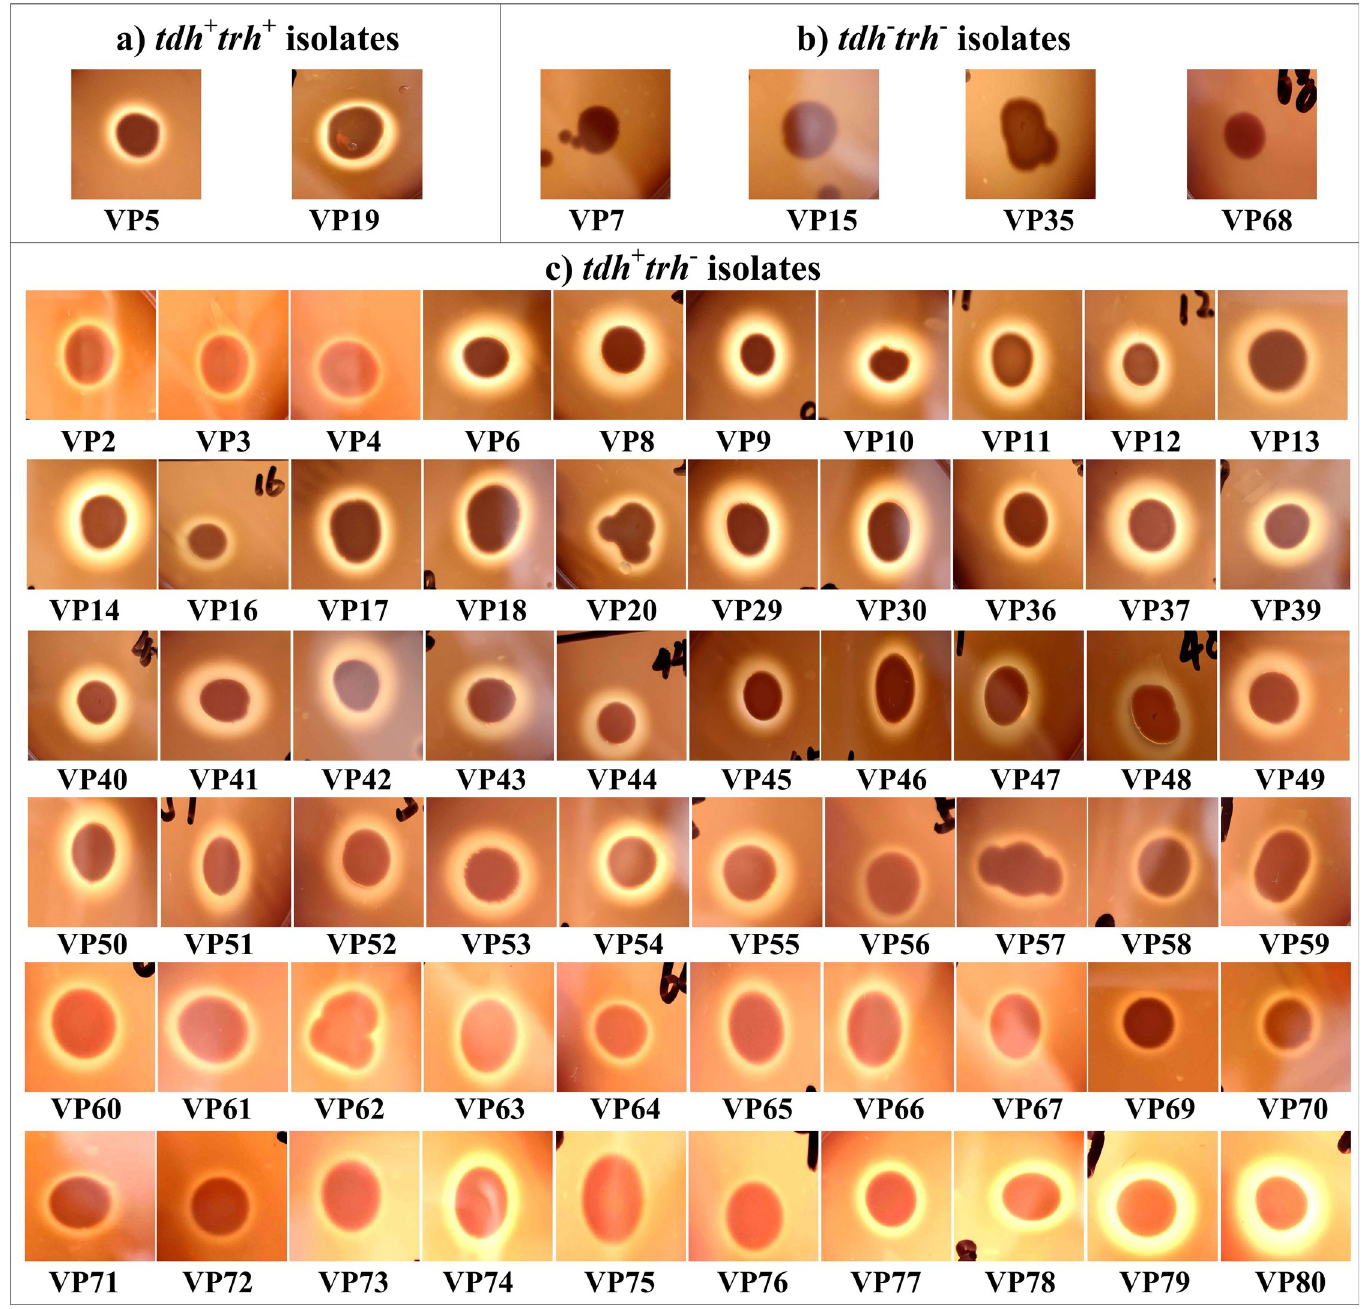
Fig 1. The hemolytic activity of V . parahaemolyticus isolates against RBCs was evaluated by observing whether there was a β -hemolysis zone surrounding the spot of growth on the Wagatsuma agar plate. The pictures shown here are representative images of V . parahaemolyticus cells on Wagatsuma agar.